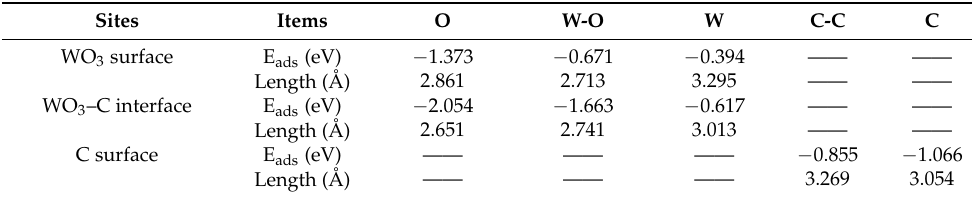
Table 2. Adsorption energy and bond length of Cd 2+ at different adsorption sites on the surface of WO 3 -nanocrystal-modified electrode.